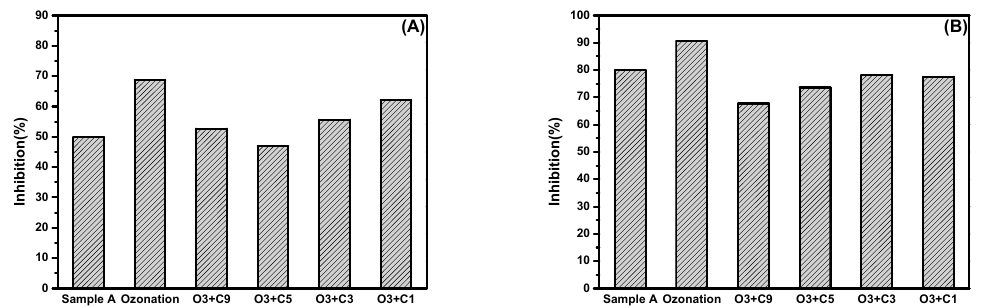
Figure 10. Changes in inhibition rates of ozonated and catalytic ozoned sample A ( A ) and sample B ( B ) to P. phosphoreum.